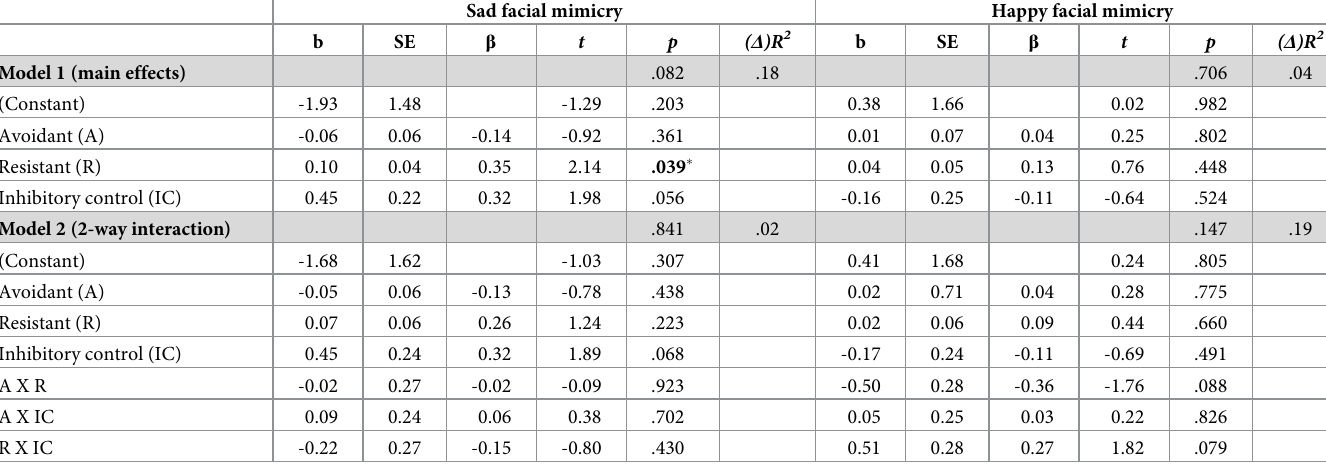
Table 2. Hierarchical regression analysis examining the interaction of avoidant (A) or resistant (R) attachment tendencies and inhibitory control (IC) in predicting facial mimicry of sad or happy facial